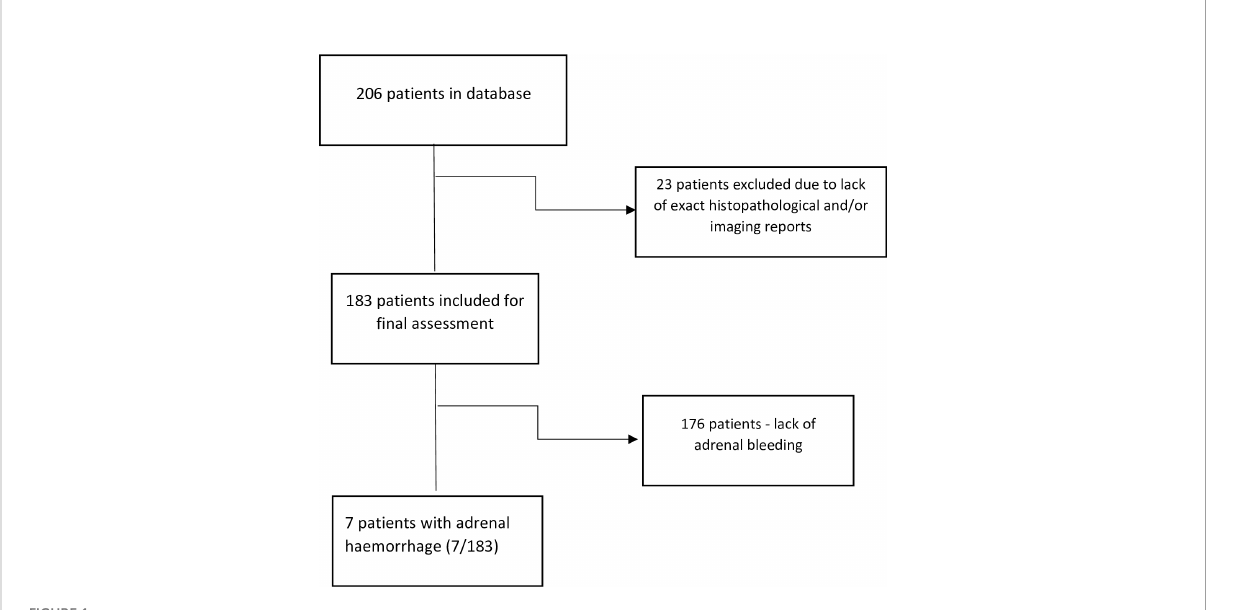
FIGURE 1 Consort diagram for the fi nal study